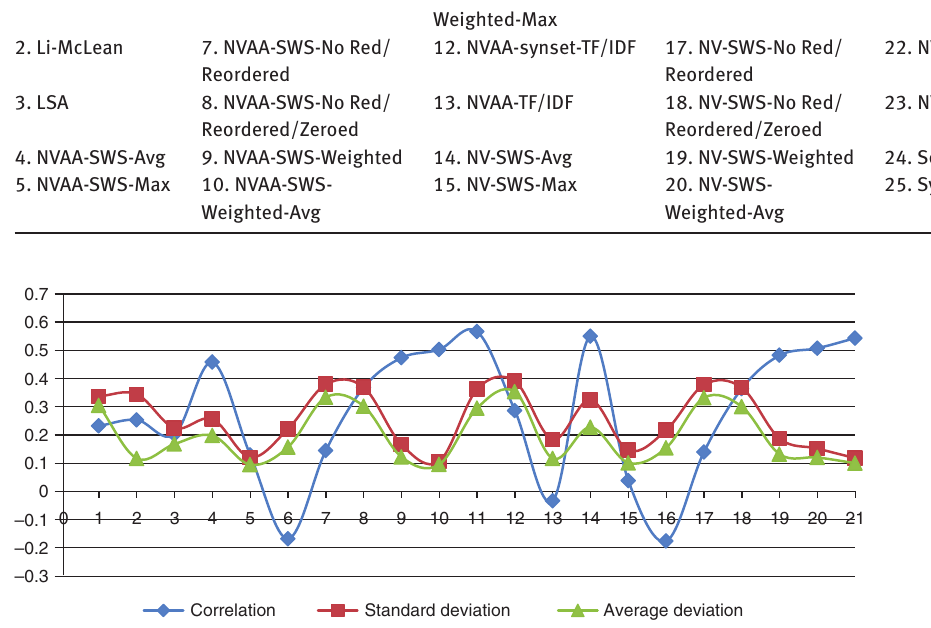
Figure 13: Results for Kaggle Brief Question Answer Evaluation Data Set for Score Class (0–1).